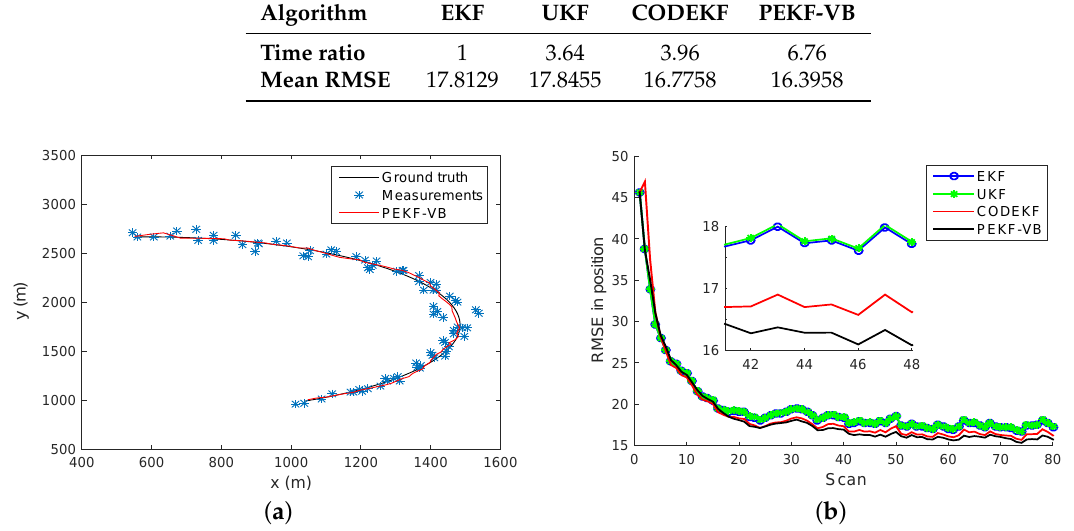
Table 1. The quantitative comparison of the mean RMSE (from 20 to 80 scan) and the running time.